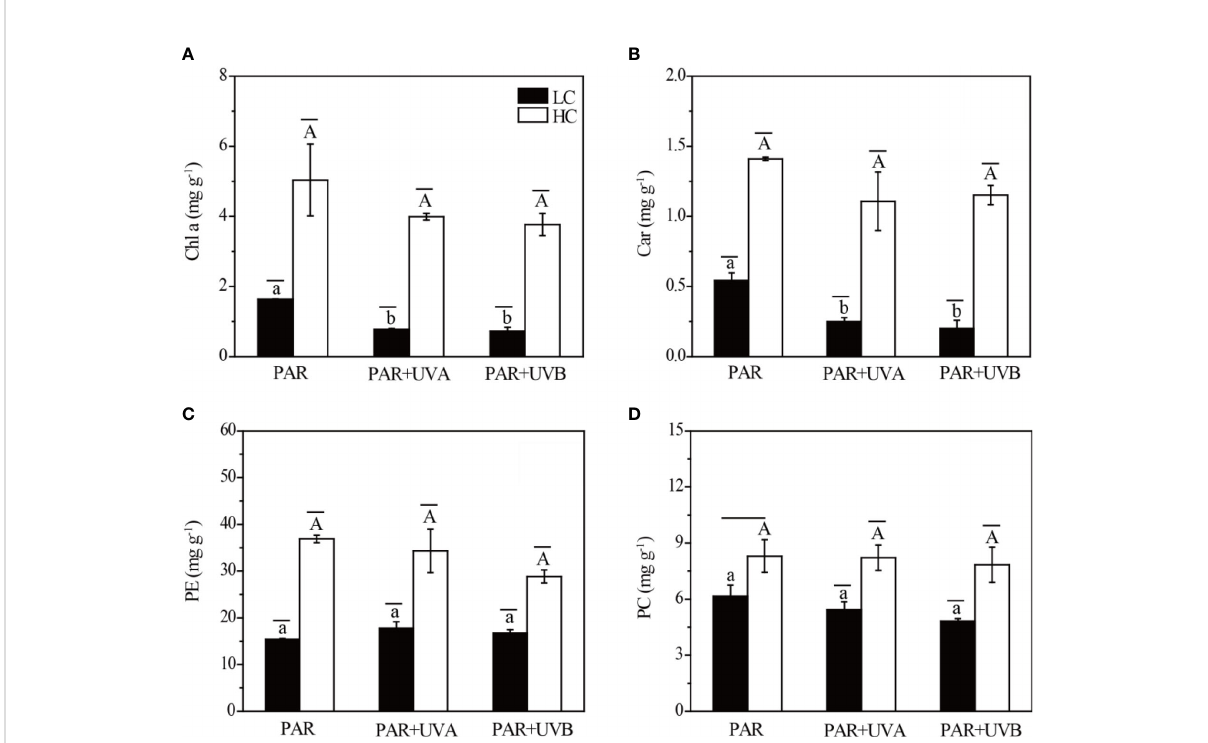
FIGURE 4 The Chl a (A) , Car (B) , PE (C) and PC (D) of Rhodosorus sp. SCSIO-45730 treated under different p CO 2 levels and UVR. Short horizontal lines represent signi fi cant differences (P<0.05) among CO 2 treatments at the same UVR treatment, while long horizontal lines indicate insigni fi cant differences. Different lowercase letters represent signi fi cant differences (P<0.05) among UVR treatments under LC, and different capital letters indicate signi fi cant differences (P<0.05) among UVR treatments under